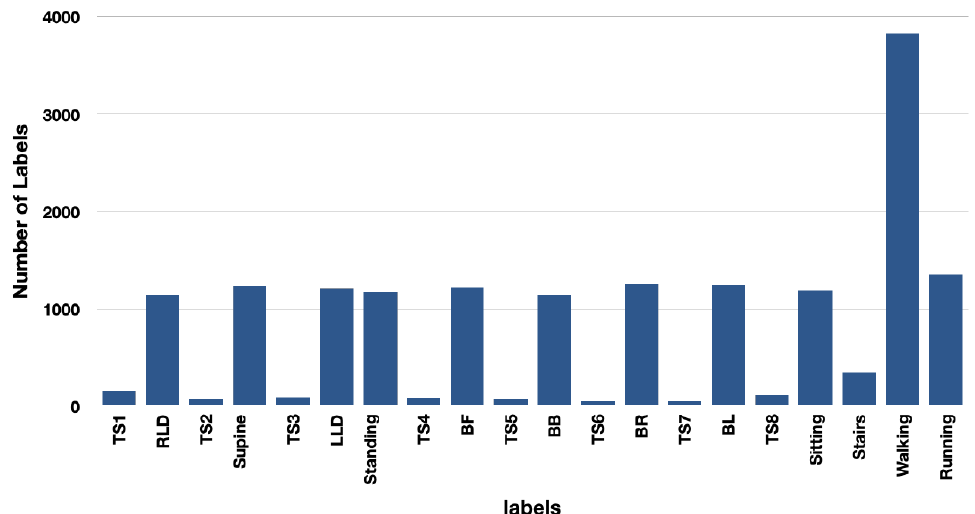
Figure 9. TSs are trained and tested with two-second window size. The number of labels for two-second window is significantly greater due to the combination of jogging and